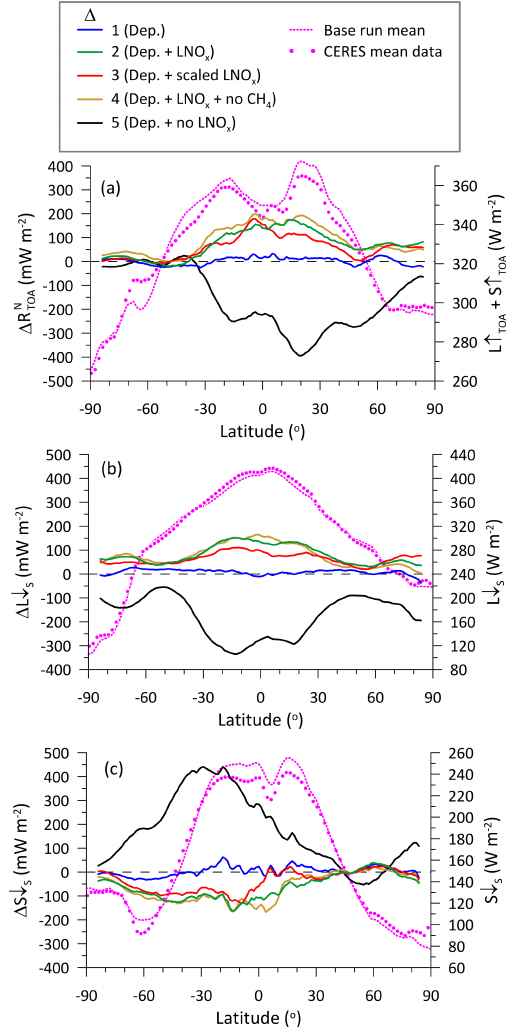
Figure 4. Zonal mean (2006–2010) of the all-sky radiative flux dif- ference between the various model runs and the base run (1 = Run B – base, 2 = Run C – base, 3 = Run D – base, 4 = Run E – base, 5 = Run F – base). The plots (solid lines) are for the (a) net down- ward TOA radiative flux difference ( (cid:49)R N ), (b) downward long- TOA wave radiative flux difference at the surface ( (cid:49)L ↓ S ) and (b) down- ward shortwave radiative flux difference at the surface ( (cid:49)S ↓ S ). The solid lines are running averages (over a moving window of ten points, i.e. 12.5 ◦ ). The zonal mean flux values obtained from the base run and the corresponding CERES-EBAF data are also plotted (dotted line and solid circles, corresponding to the right y